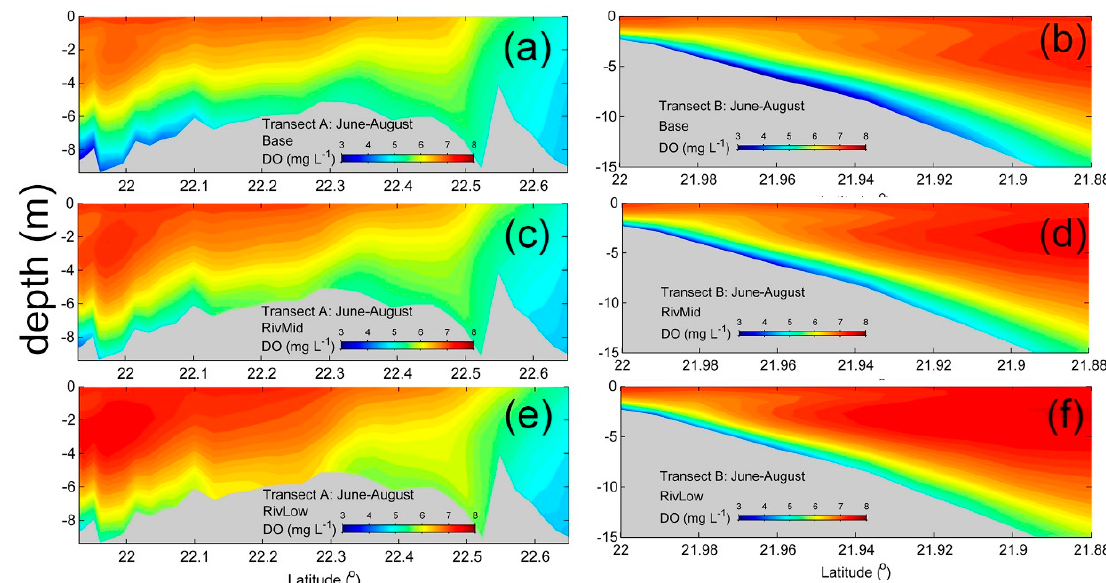
Figure 7. Spatial distribution of the simulated DO concentration ( a – c ) and the hypoxic frequency (HF) ( d – f ) in the bottom layer for the base ( a,d ), RivMid ( b , e ), and RivLow ( c , f ) cases. The red rectangle in ( d ) is the calculated area of the DO budget.